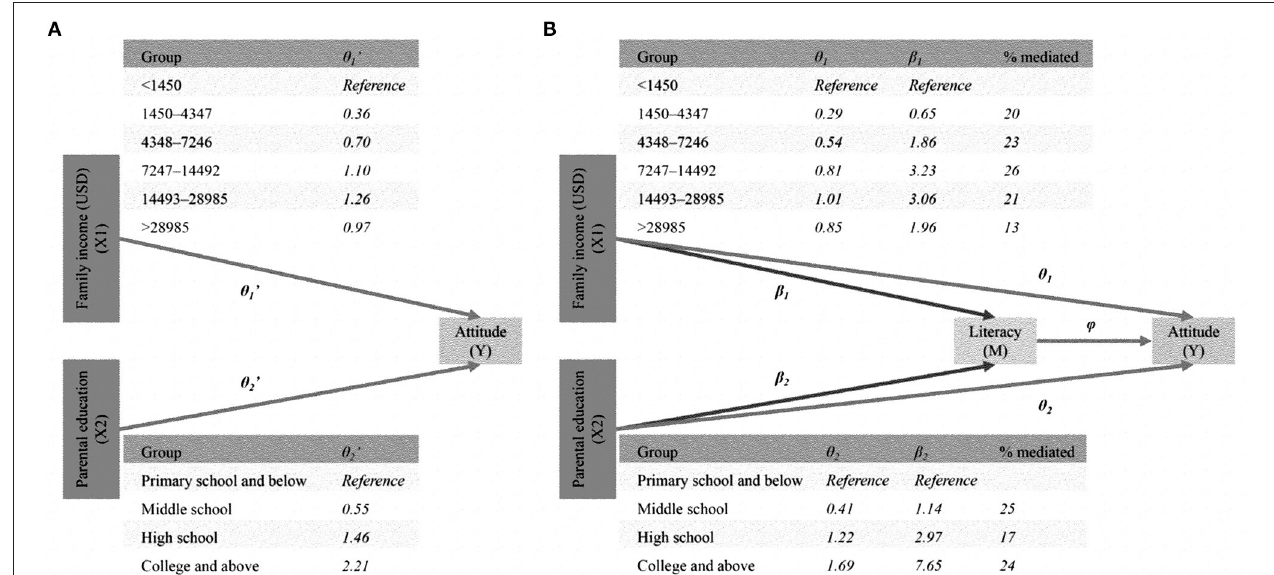
FIGURE 3 | Medication model: SES (X1: income; X2: education) → literacy (M) → attitudes (Y). (A) Total effect. (B) Direct and medication effect.